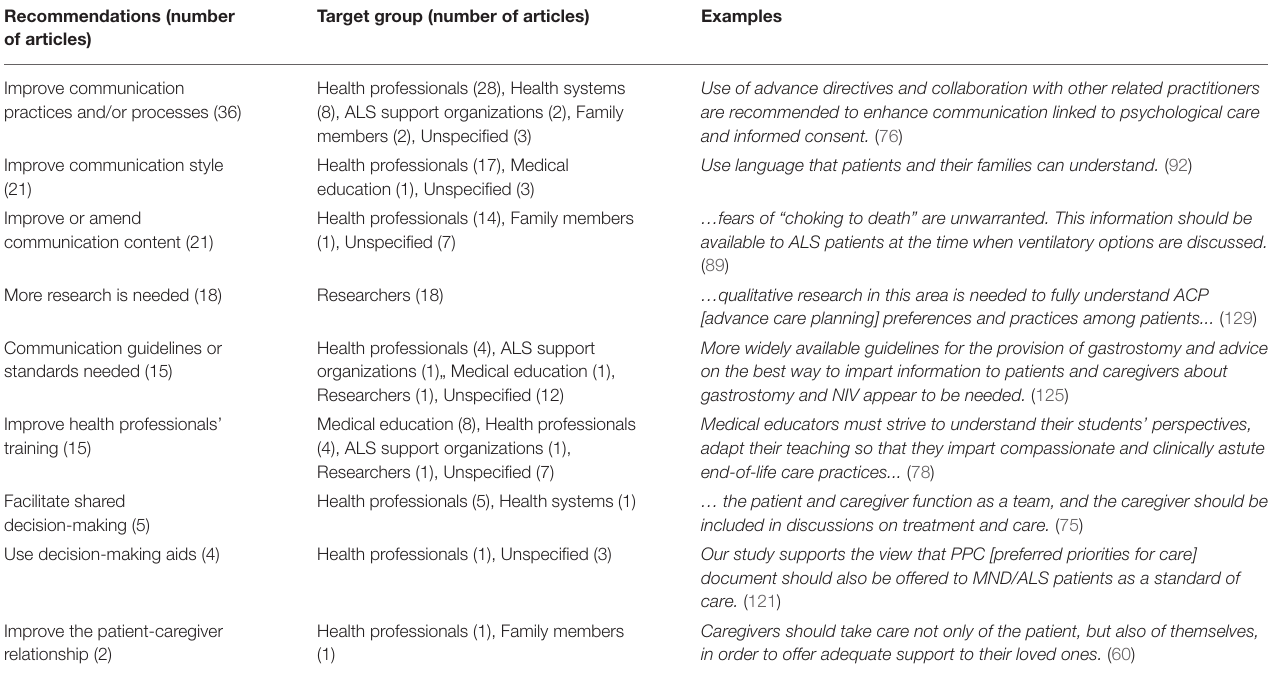
TABLE 6 | Actionable recommendations for improving health communication ( n =